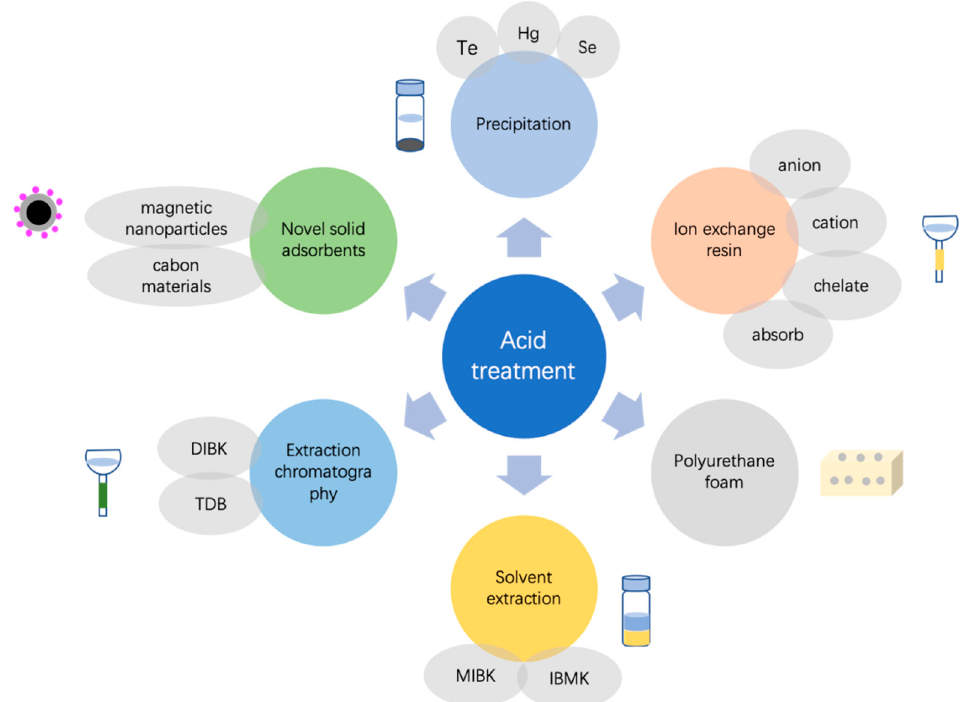
Figure 4. Common preconcentration methods used with wet acid digestion.